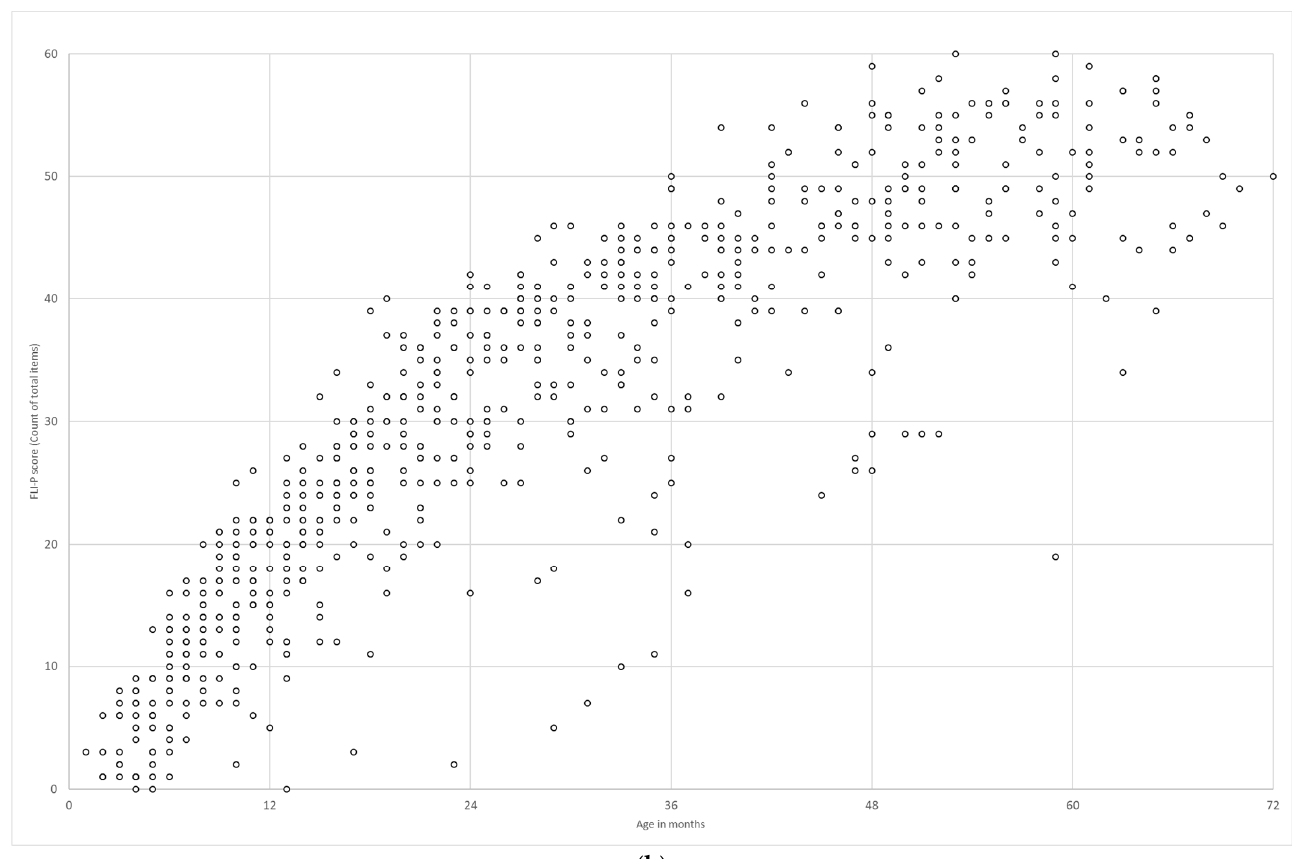
Figure 10. FLI-P scores between groups of children who ( a ) received a refer newborn hearing screening result and ( b ) who received a